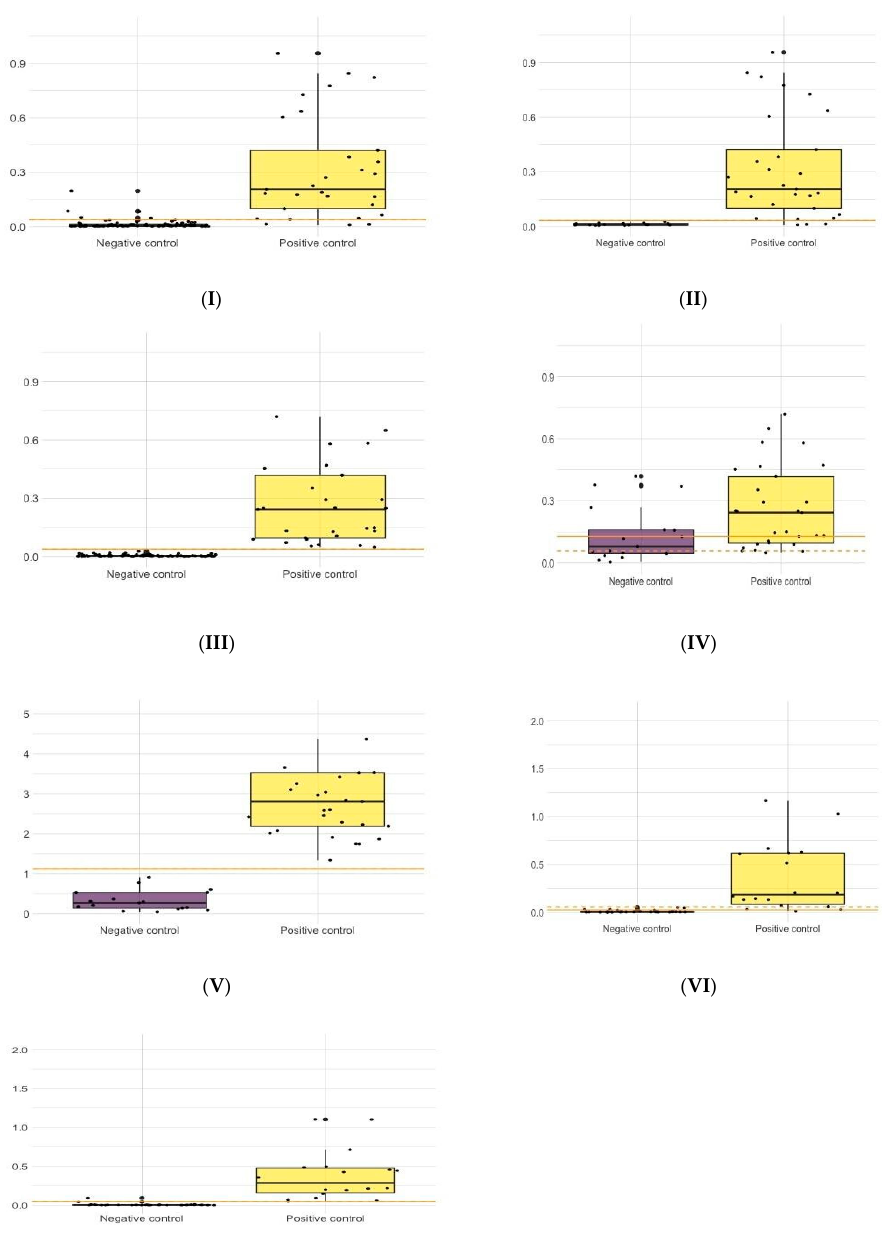
exception of the B. suis 1330 smooth antigen between groups A and C in domestic pigs.